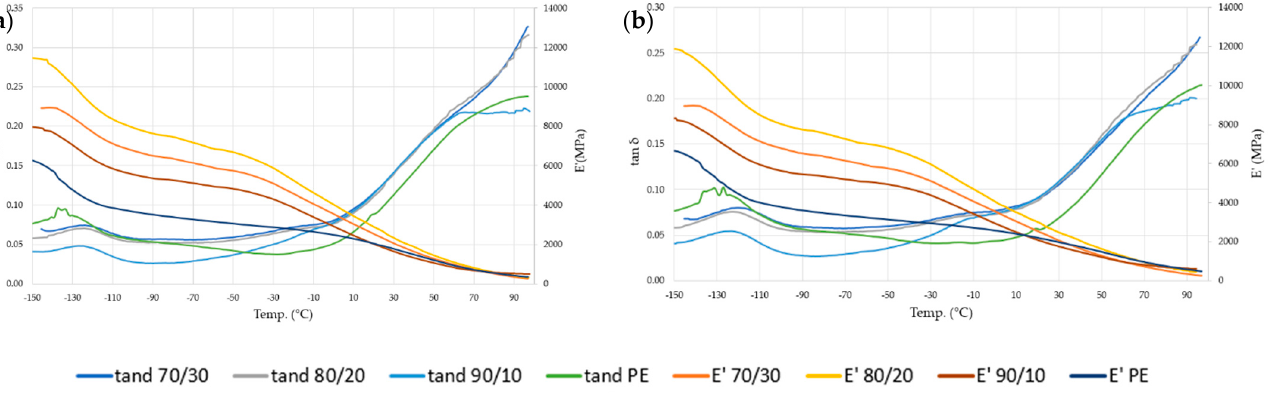
Figure 12. DMTA charts for flakes samples: ( a ) vibration frequency 1 Hz, ( b ) 10 Hz.